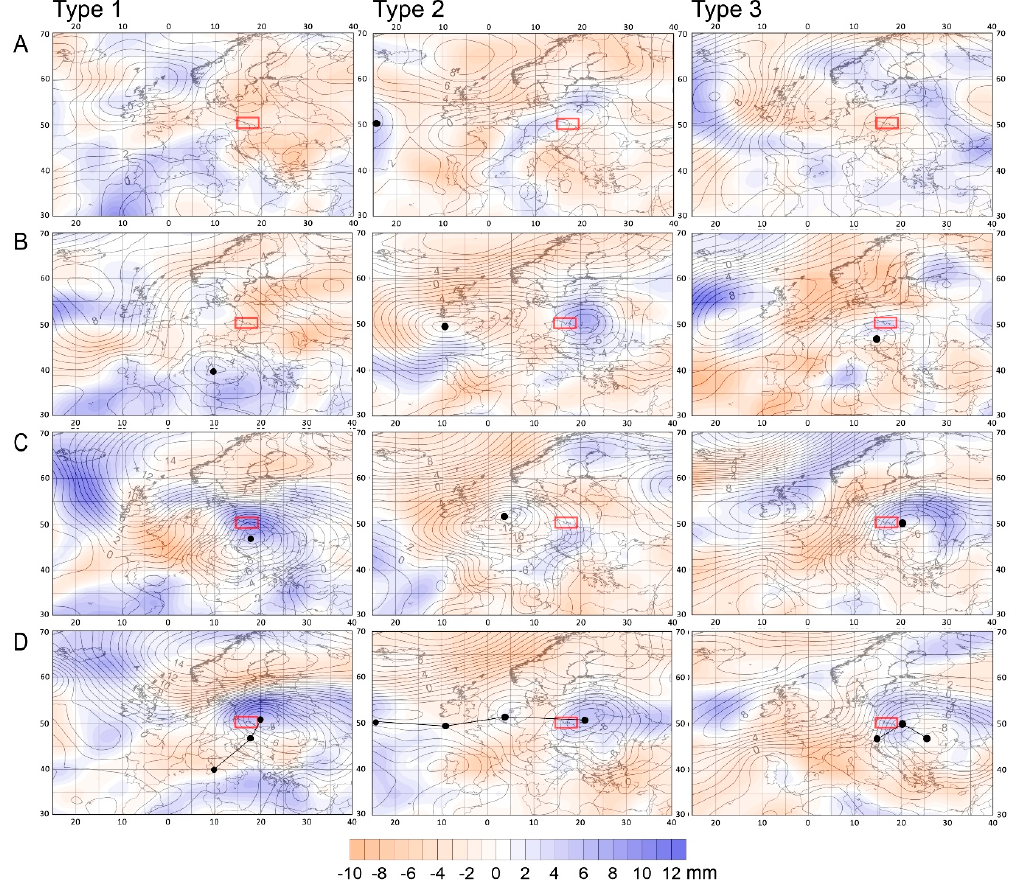
Figure 5. Circulation types 1, 2 and 3 mean SLP (hPa) (solid lines) and PW (mm) (colour scale) anomalies 6 days ( A ), 4 days ( B ), and 2 days ( C ) before the flood culmination and on the flood culmination day ( D ); black dots indicate centers of negative SLP anomalies and in column D cyclone tracks are marked; region of Polish Sudeten Mountains marked as red rectangle.